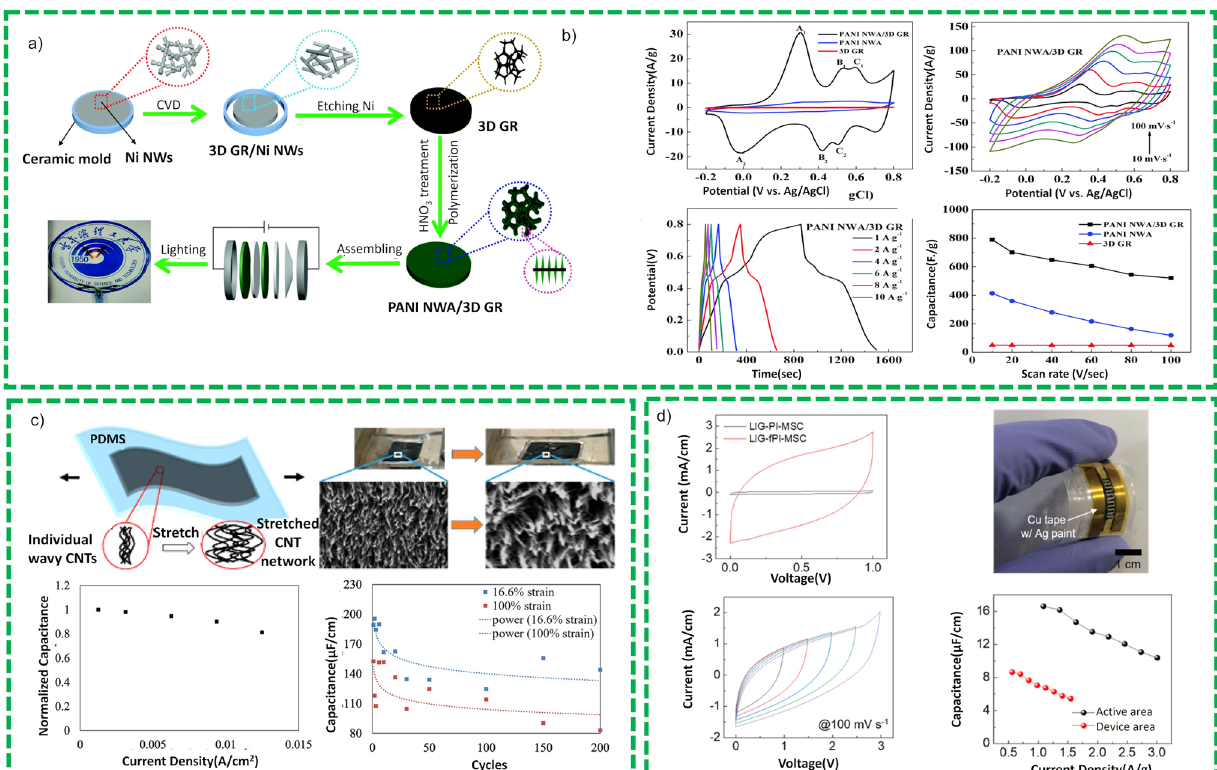
Fig. 15 a Graphical representation of PANI/3D graphene electrode fabrication and then assembling in SCs device, b electrochemical characteri- zation of the composite electrode CV, GCD, performance comparison, Reprinted with permission from Ref. [133]. c Graphical representation of fabrication process and demonstration of the shape change woven CNTs on PDMS under strain condition via APCVD, synthesized CNTs are moderately inserted in PDMS, adhesion of CNTs with PDMS in stretched conditions along with electrochemical characterization. Reprinted with permission from Ref. [134]. d Electrochemical characterization of both materials in 1 M H 2 SO 4 at 0.005 V s −1 , picture of pouch cell, sta- bility in different voltage windows, specific capacitance as function of current density, cyclic and bending stability in different bending radius. Reprinted with permission from Ref.